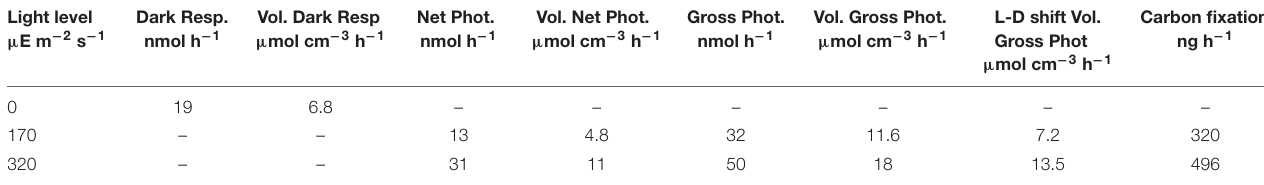
TABLE 1 | Rates of respiration and photosynthesis for green